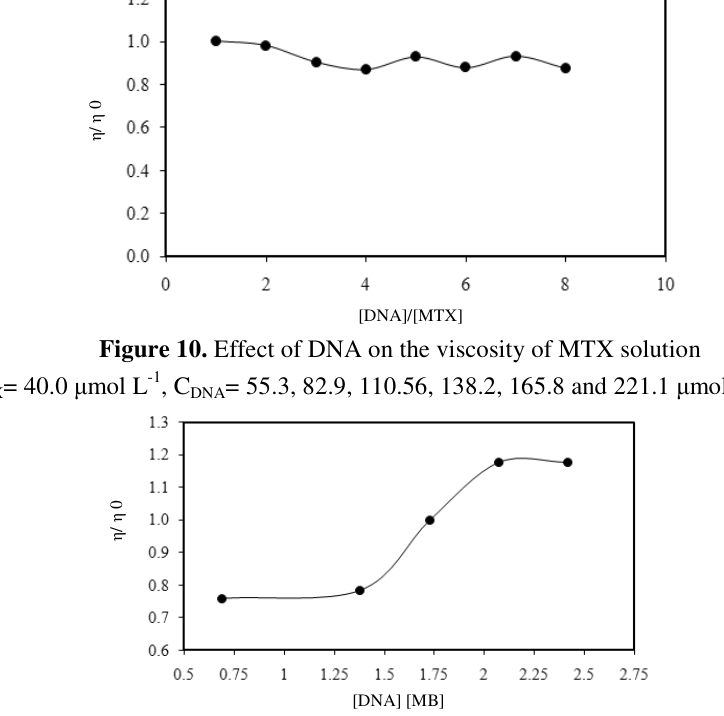
Figure 11. Effect of DNA concentration on the viscosity of MB (40.0 µ mol L -1 ) C = 27.6, 55.3, 69.1, 82.9 and 96.7 µ mol L -1 at 298 DNA